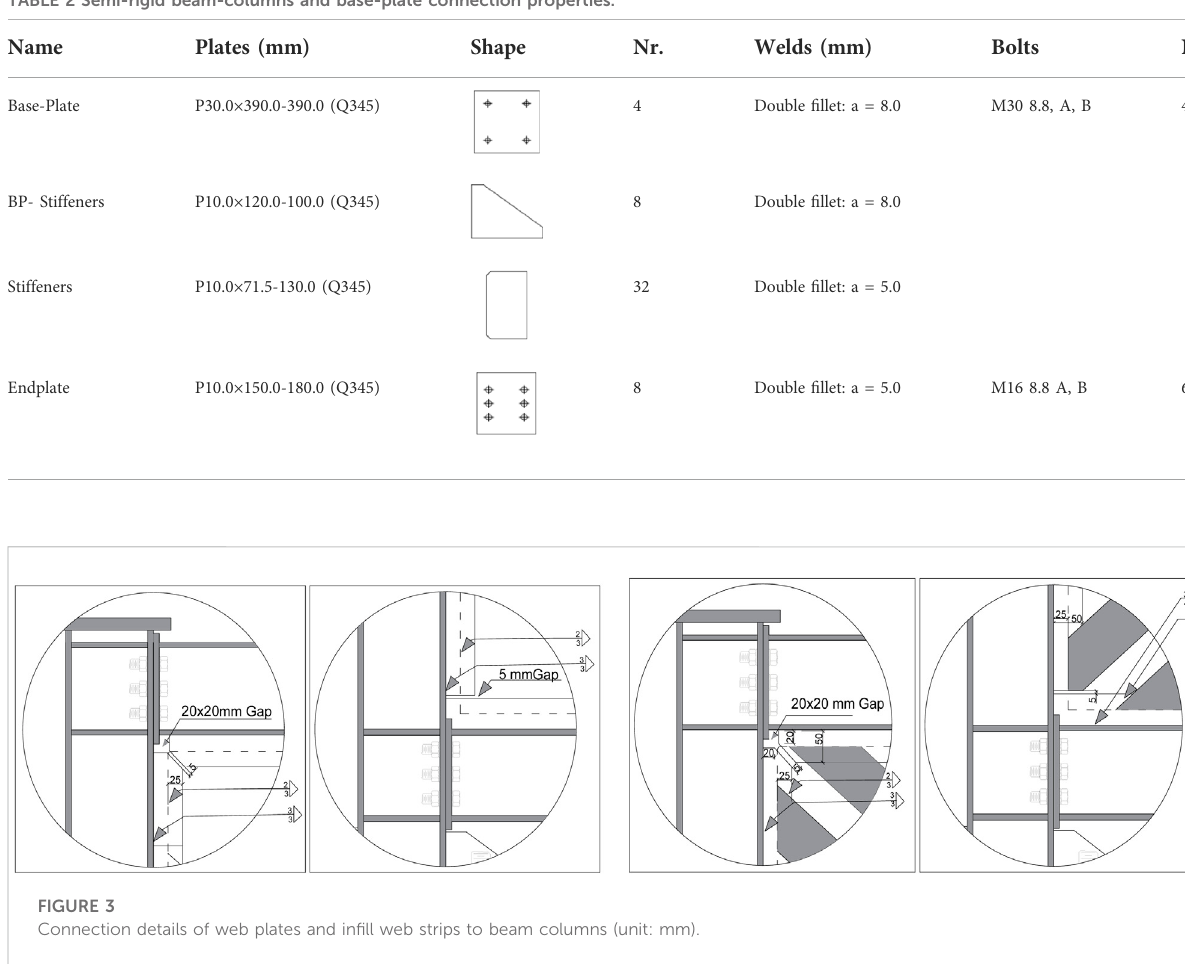
TABLE 2 Semi-rigid beam-columns and base-plate connection properties.